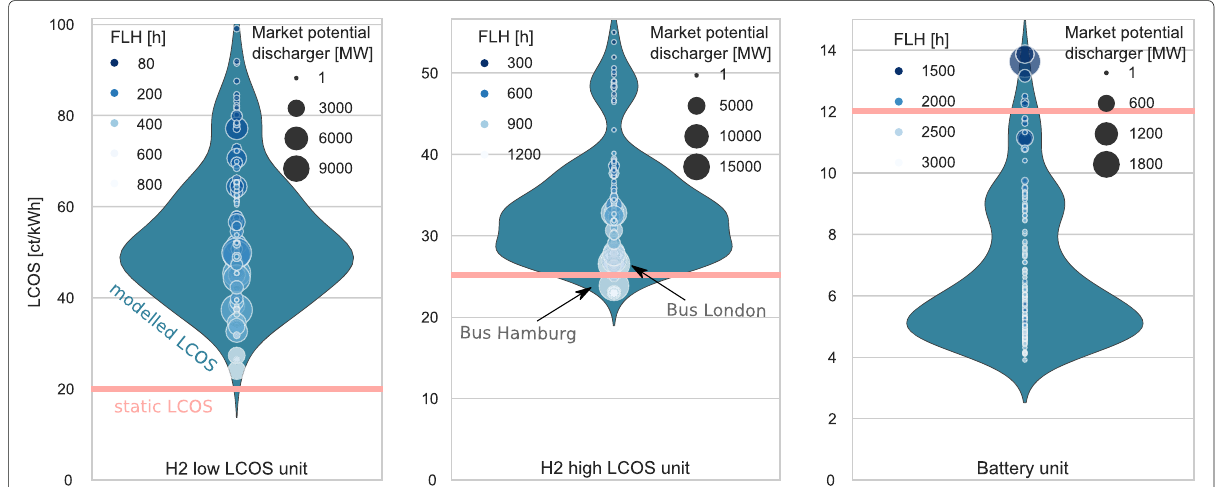
Fig. 8 Static LCOS results compared to European wide modelled LCOS. The static LCOS is marked by a red horizontal line and was calculated for a set of assumption in Table 4. In contrast, the modelled LCOS is given as points and uses spatial-temporal dissolved European energy modelling outputs for its calculation. The size of each point shows the optimised market potential of discharger in a given region and helps indicating the relevance. The colour reveals full load hours for each storage technology and helps understanding the operational behaviour which partially lead to the LCOS. The width of the violin plot shows the occurrence in the kernel density estimation, hence, the wider the plot the more buses are located at the respective LCOS cost range. In all cases, buses with less than 1 MW market potential or 80 FLH are removed, keeping the visualisation readable